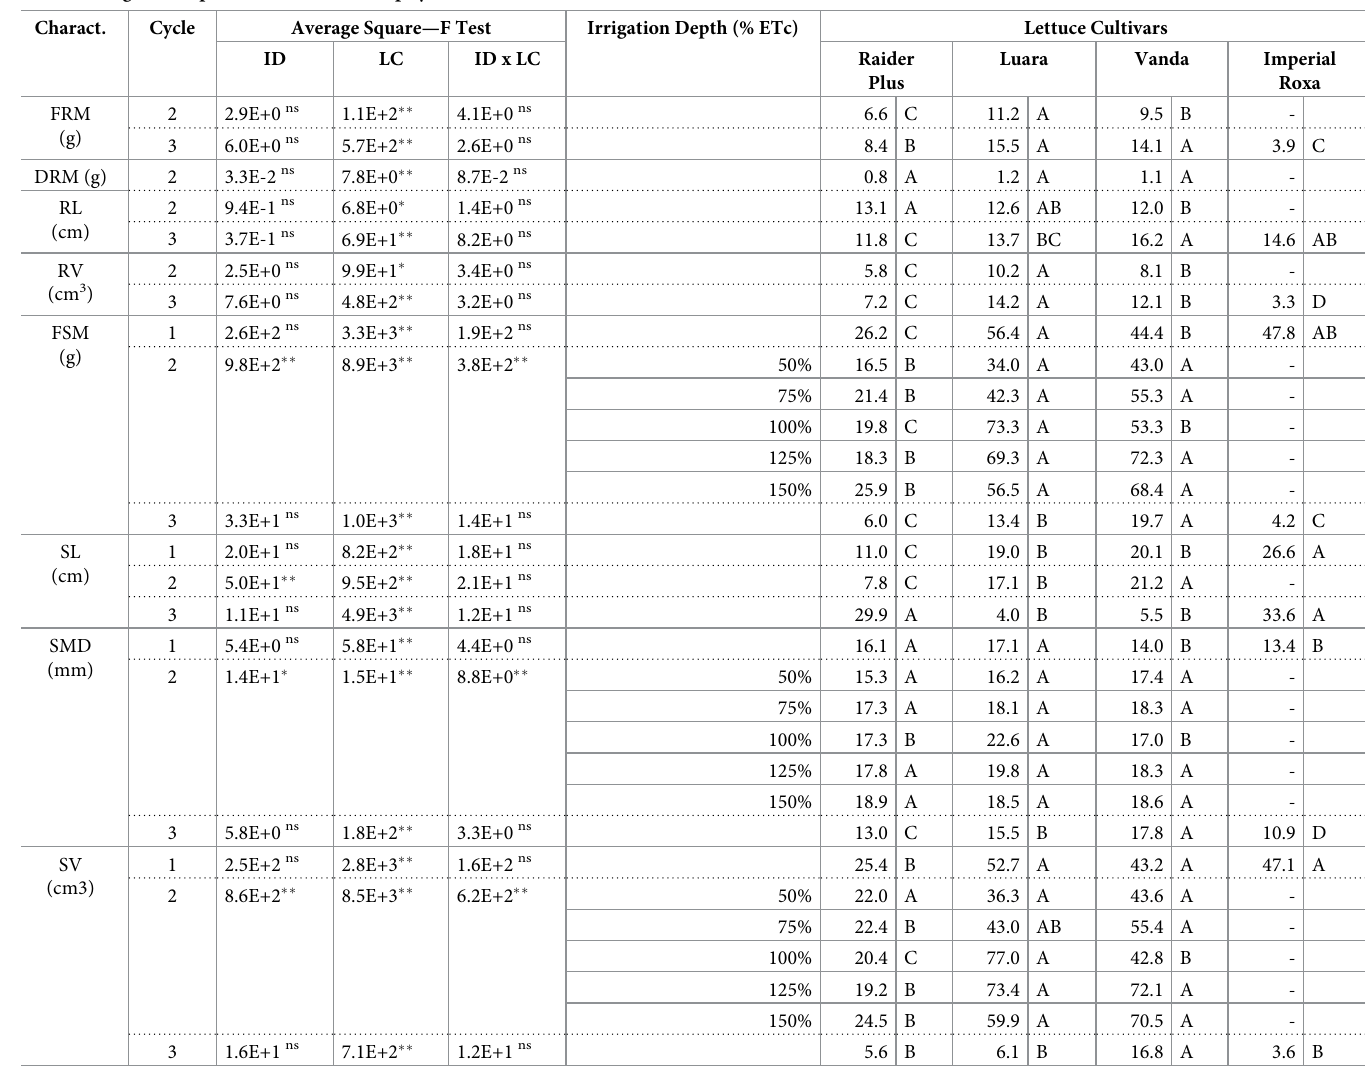
Table 4. Average square significance of the F test (ANOVA) and average values for characteristics of roots and stems: fresh root mass (FRM), dry root mass (DRM), root length (RL), root volume (RV), fresh stem mass (FSM), stem length (SL), stem average diameter (SMD) and stem volume (SV) as a function of different culti- vars and irrigation depths in three lettuce crop cycles.